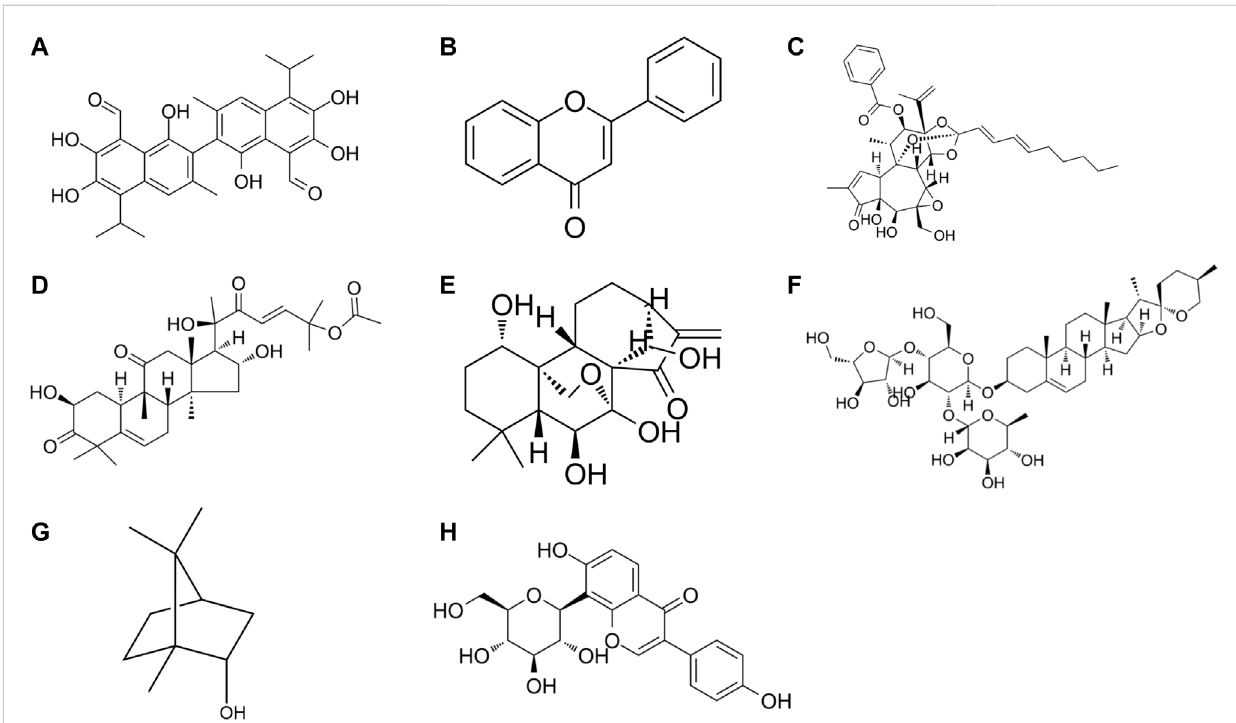
FIGURE 2 The chemical formula of drug monomers (A) Gossypol, (B) Flavone, (C) Yuanhuadine, (D) Cucurbitacin B, (E) Oridonin, (F) Polyphyllin I, (G) natural borneol, (H) Puerarin.